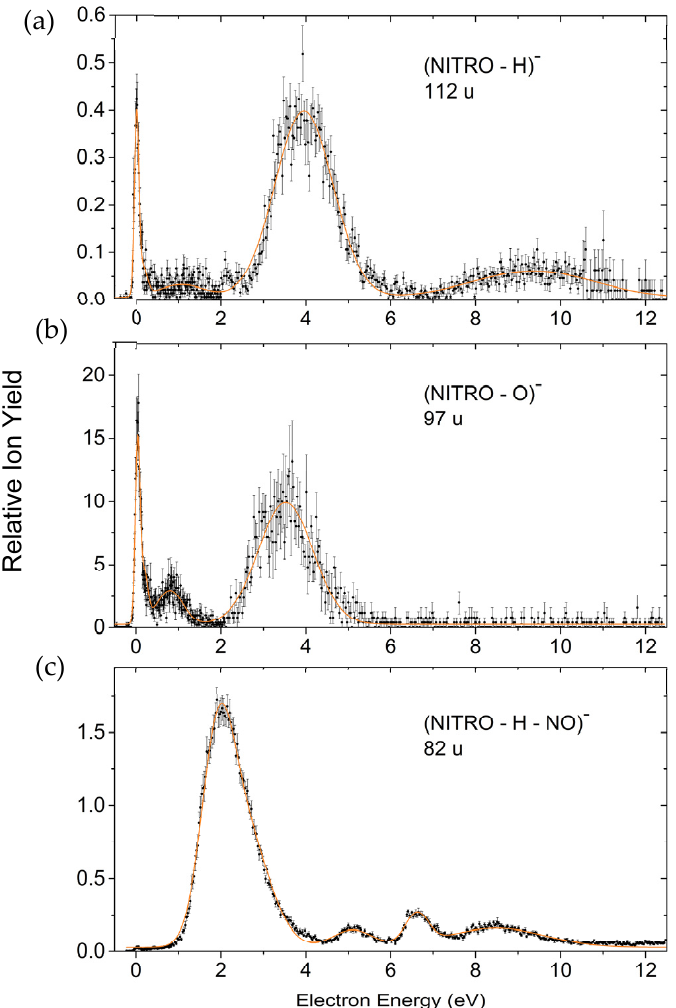
Figure 5. Relative ion yields for the formation of the dehydrogenated closed shell nitroimidazole anion ( a ), the nitroimidazole anion subjected to the additional loss of a neutral O unit ( b ), and the nitroimidazole anion subjected to the additional loss of a neutral NO unit ( c ).